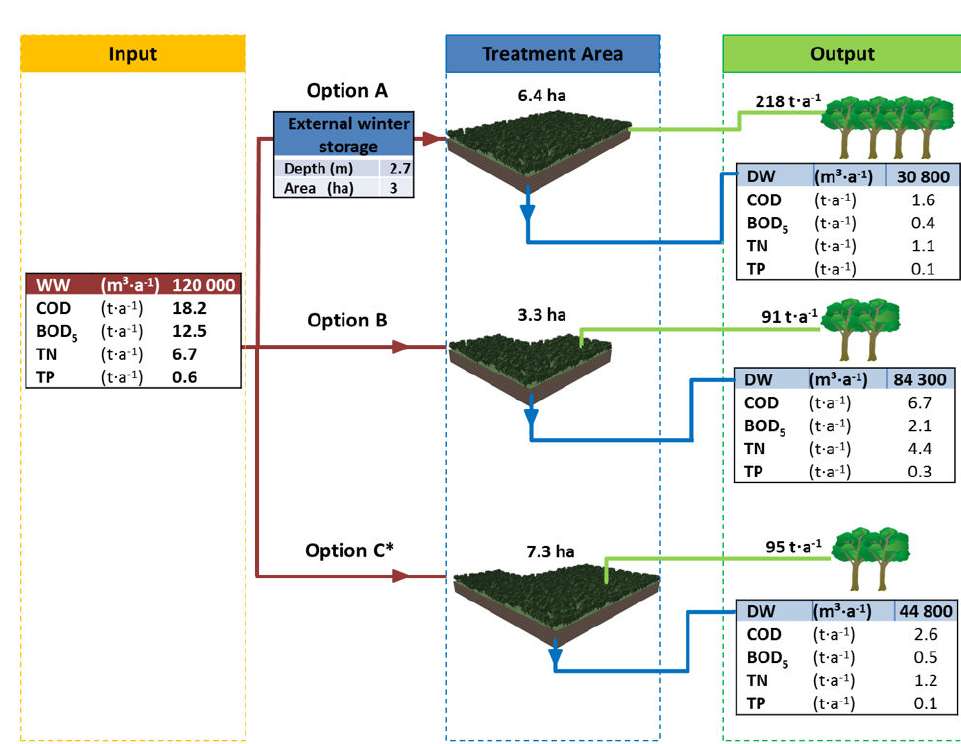
Figure 7. Design recommendation for three potential options. The design recommendation for option C* is based on the results reported by Khurelbaatar et al. [1]. Option A represents the external winter storage and only summer irrigation of the short rotation coppice system. Option B and C show the internal winter storage, where the wastewater is stored on the tree-planted area of the short rotation coppice system. The daily loading rate for option A and B are the same, while option C has a lower loading